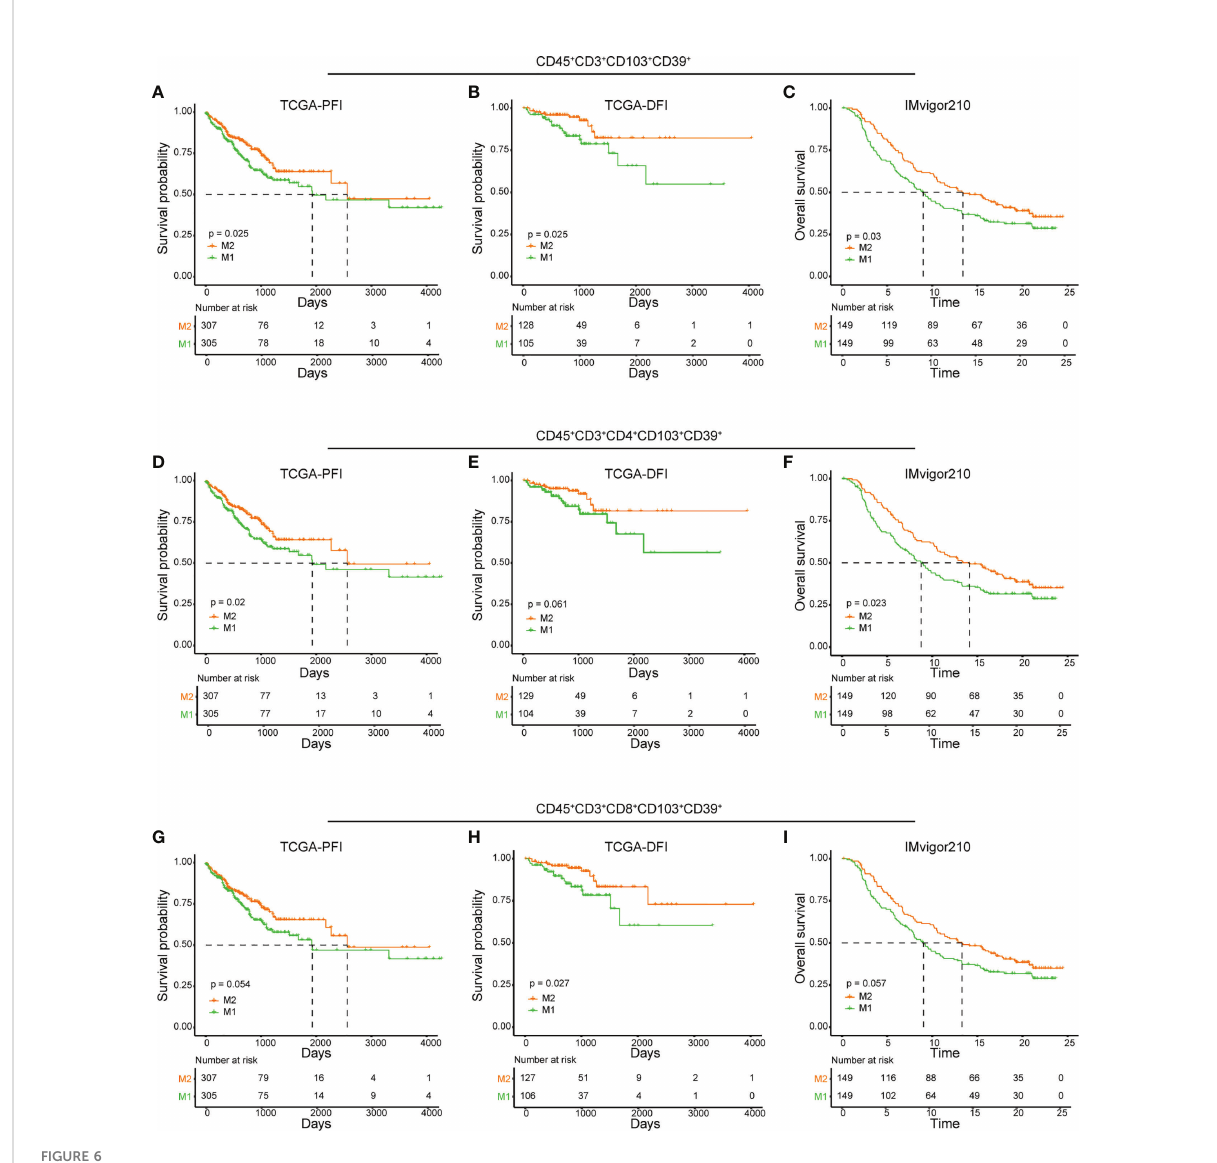
FIGURE 6 Predictive value of CD45 + CD3 + CD103 + CD39 + phenotype in prognosis and immunotherapy. (A, D, G) Kaplan-Meier plots of relationship between the immune signatures from RNAseq dataset (CD45 + CD3 + CD103 + CD39 + (A) , CD45 + CD3 + CD4 + CD103 + CD39 + (D) and CD45 + CD3 + CD8 + CD103 + CD39 + (G) and PFI in TCGA cohort. Patients were strati fi ed according to the median of signature NES, where M1 was the lower NES and M2 was the higher NES. B, E, (H) Kaplan-Meier plots of relationship between the immune signatures from RNAseq dataset (CD45 + CD3 + CD103 + CD39 + (B) , CD45 + CD3 + CD4 + CD103 + CD39 + (E) and CD45 + CD3 + CD8 + CD103 + CD39 + (H) and DFI in TCGA cohort. Patients were strati fi ed according to the median of signature NES, where M1 was the lower NES and M2 was the higher NES. C, F, (I) Kaplan-Meier plots of relationship between immune signatures from RNAseq dataset (CD45 + CD3 + CD103 + CD39 + (C) , CD45 + CD3 + CD4 + CD103 + CD39 + (F) and CD45 + CD3 + CD8 + CD103 + CD39 + (I) and OS in IMvigor210 cohort. Patients were strati fi ed according to the median of signature NES, where M1 was the lower NES and M2 was the higher